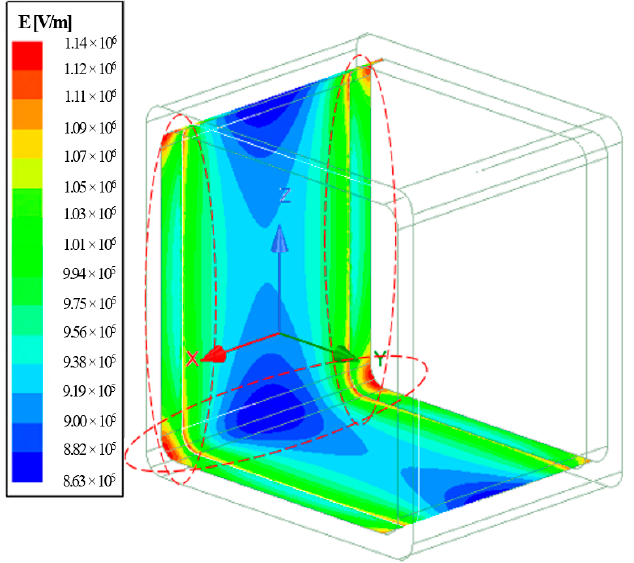
Figure 18. E ‐ field stress on the internal surfaces of GFRP crossarm sample.